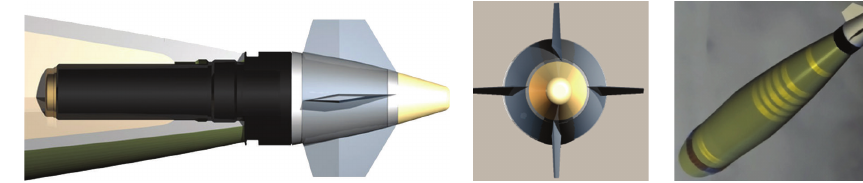
Figure 9: Canard based-correction fuze.